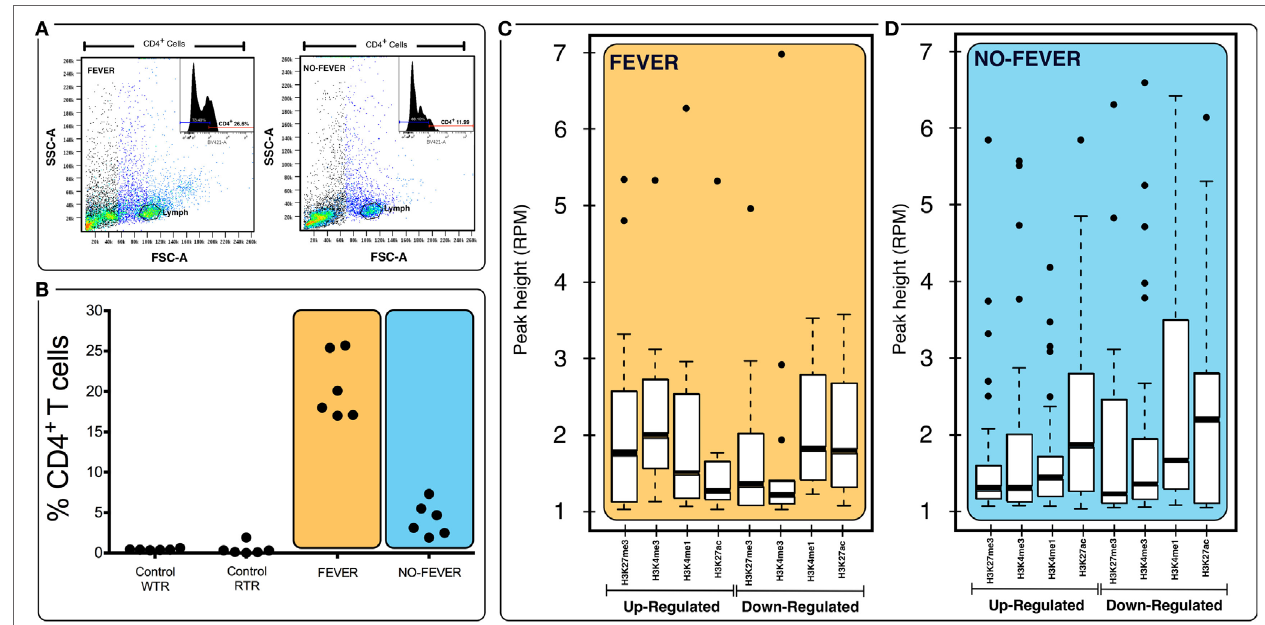
FigUre 7 | Effects of tissue composition mediated regulation on fever behavior and temperature gene expression levels. (a) Behavioral fever individuals exhibit higher proportions of CD4 + T cells in pronephros tissue ( p = 0.031, n = 60; y -axis shows the percentage of T-cell proportions after infectious pancreatic necrosis virus challenge). Panel (B) shows the lymphocyte population and the inset show an example data for histogram of fever and no fever individuals; x axis shows staining for CD4 + (helper) T cells (% of cells positive for CD4-BV421 antibody). (c,D) Box plots for chromatin immunoprecipitation-seq RPM values of fever and no fever group of genes. Box plots of adjusted (adj.) input normalized H3K4me3 reads per kilobase per million mapped reads (RPKM), (c) values at TSS (fever genes, n = 1,726) (D) and TSS-containing domains (no fever genes, n = 1,369). Box and whiskers correspond to the highest and lowest points within the 1.5 × interquartile